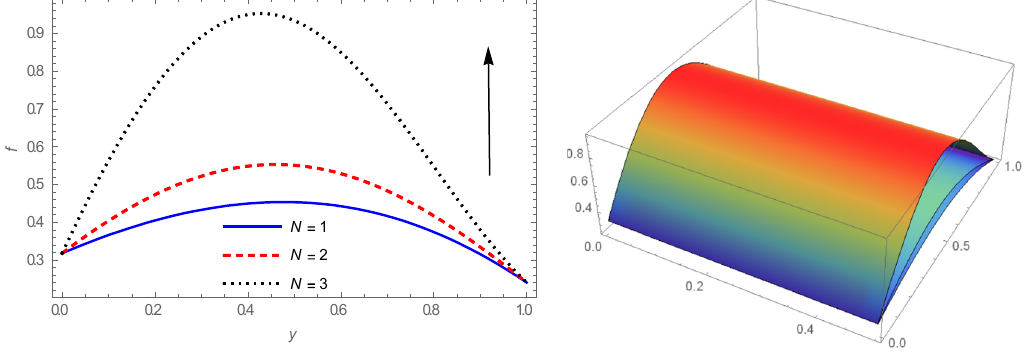
Figure 9. Impact of (cid:1840) on velocity distribution.